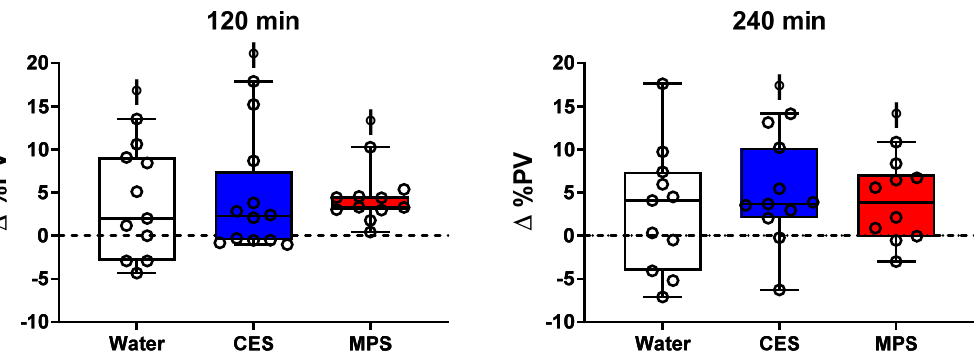
Figure 5. Changes in plasma volume at 120 and 240 min post-ingestion. Plasma volume was significantly elevated in all three beverages compared to Pre at 120 min and only in CES and MPS at 240 min. There were no significant differences in changes in plasma volumes between beverages at both time points. Boxes represent first and third quartiles with median values denoted by the horizontal line, while whiskers indicate minimum and maximum observations. Individual subjects’ changes in plasma volume are displayed as open circles. Differences between beverages were assessed by two-way ANOVA. ꬹ p < 0.05 compared to Pre.